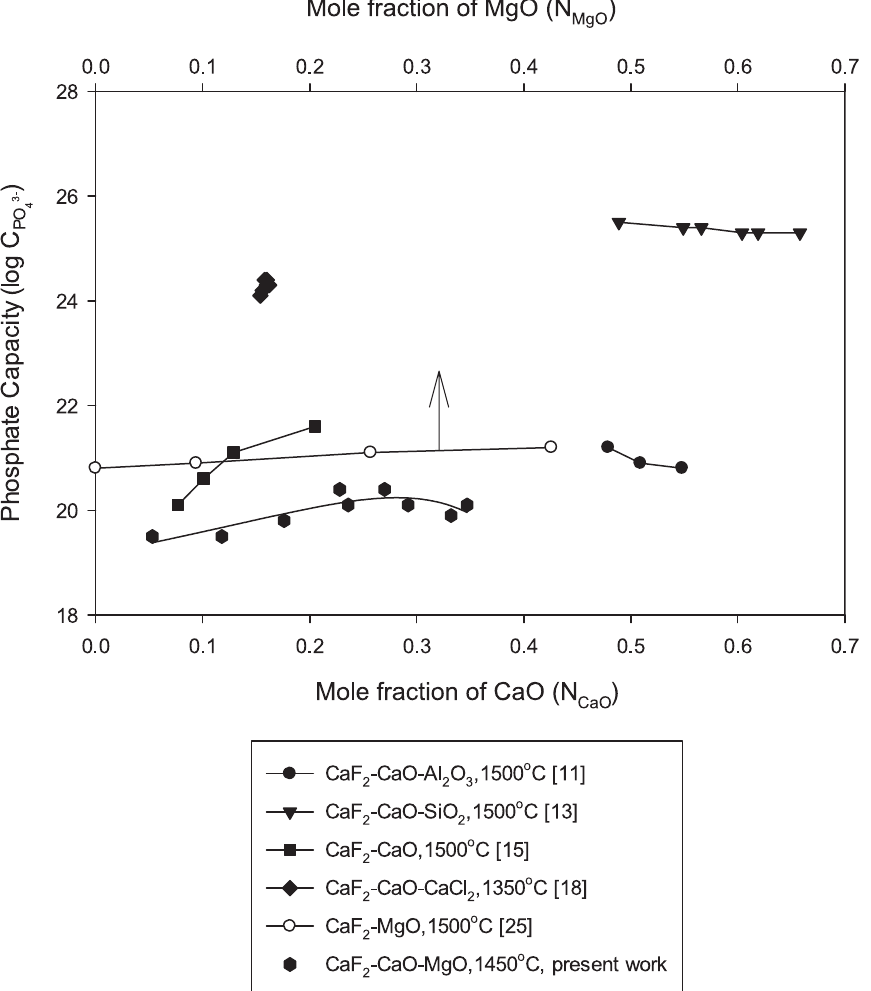
Fig. 4: Comparison of phosphate capacity of various CaF 2 -containing slags with the results of the present